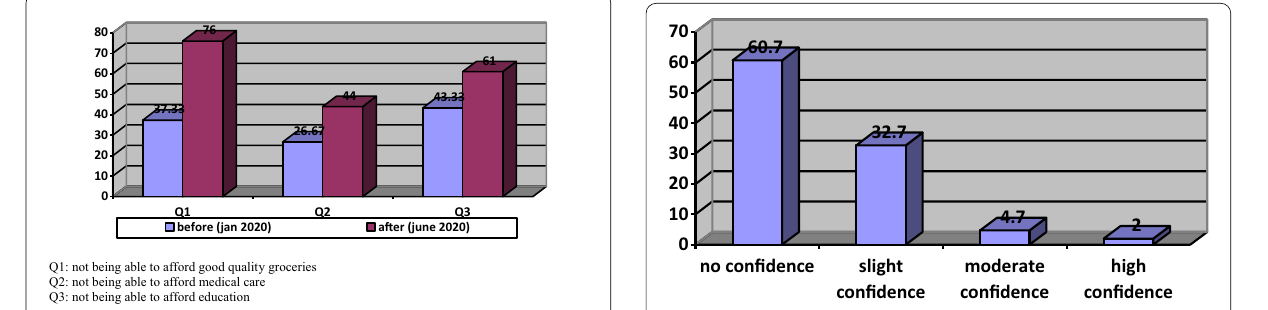
Fig. 7 Percentages of households who unable to afford